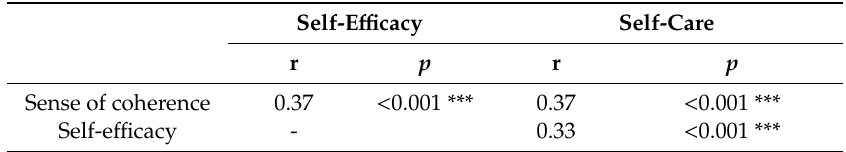
Table 2. Bivariate Pearson’s correlations between sense of coherence, self-e ffi cacy and self-care at study entry. Self-E ffi